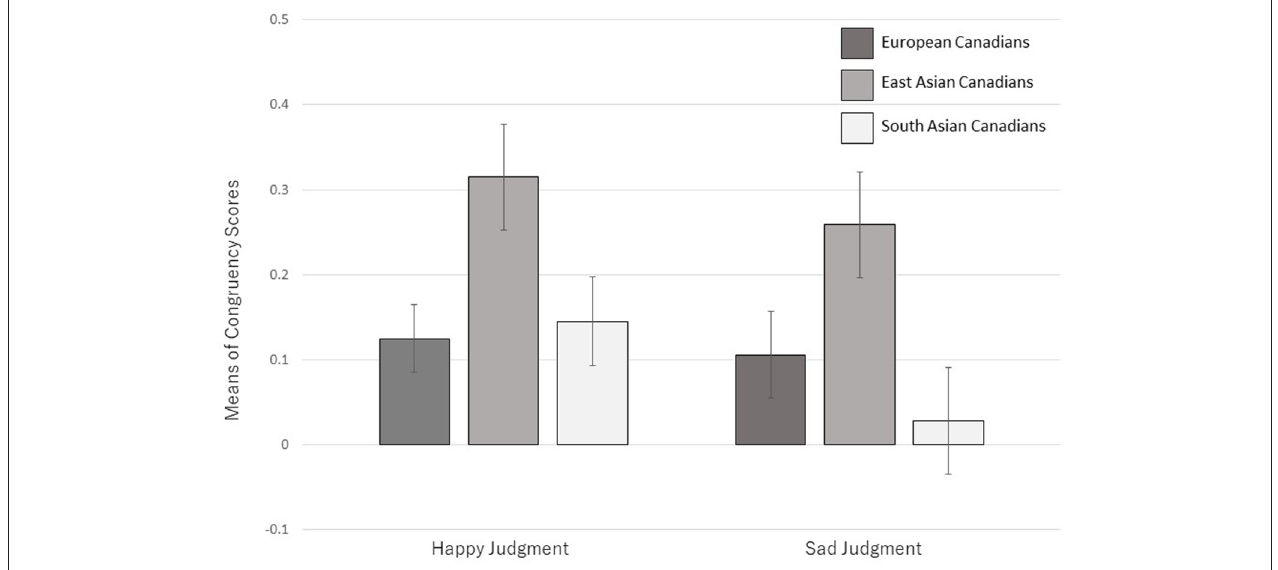
FIGURE 4 | Comparison of congruency scores for the happy judgment and the sad judgment between the three cultural groups: European Canadians, East Asian Canadians, South Asian Canadians.